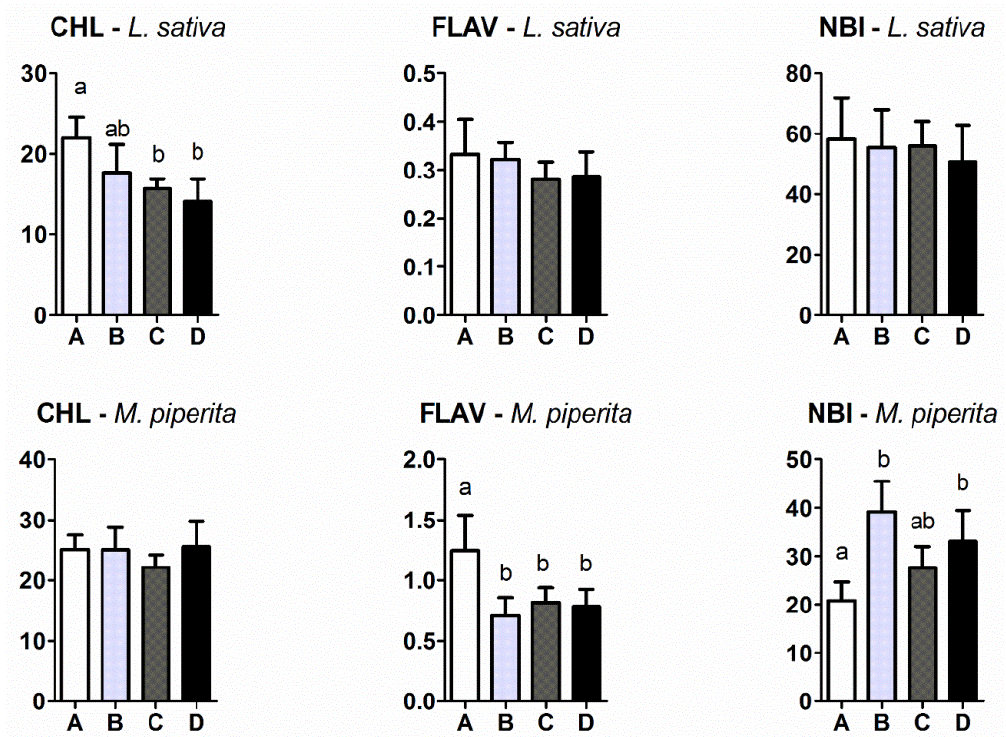
Figure 4. Chlorophyll content (CHL), phenolic compounds (FLAV), and chlorophyll to flavonol ratios (NBI) measured in lettuce and mint leaves in each experimental group. Values are means ± SD. Different lower-case letters indicate significant differences (p < 0.05 ) ; n = 6.